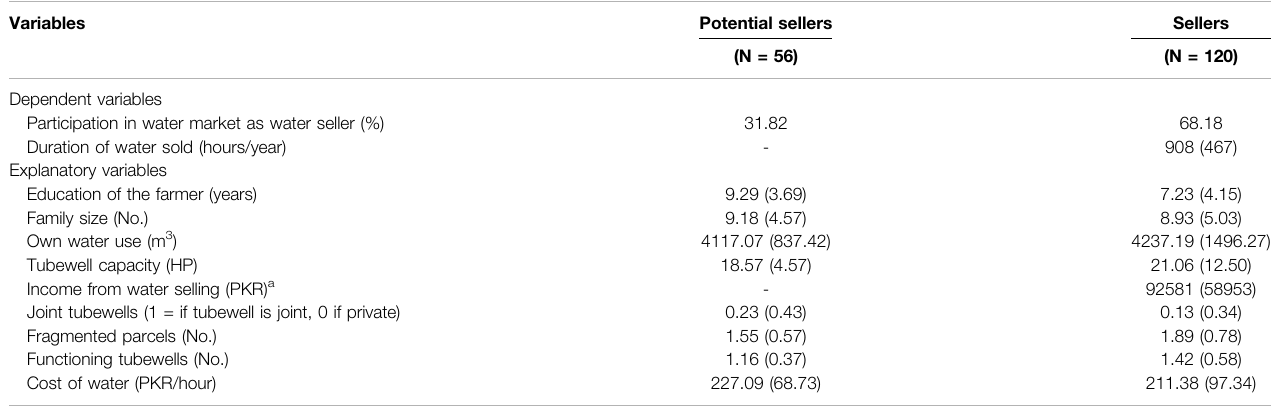
TABLE 4 | Summary statistics of variables used in the econometric model on per farm basis of water sellers. Variables Potential sellers